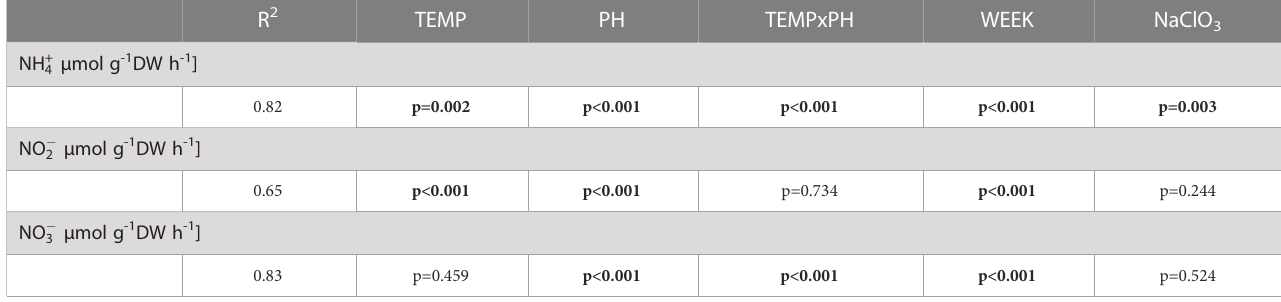
TABLE 6 R 2 of fi nal linear regression models with signi fi cance of Temperature (TEMP), pH (PH), two-way interaction (TEMP x PH), week (WEEK) and addition of inhibitor sodium chlorate (NaClO 3 ) for nutrient fl ux (ammonium NH + 4 , nitrite NO 2 and nitrate NO 3 ) [µmol g -1 DW h -1 ]. R 2 TEMP PH TEMPxPH WEEK NaClO